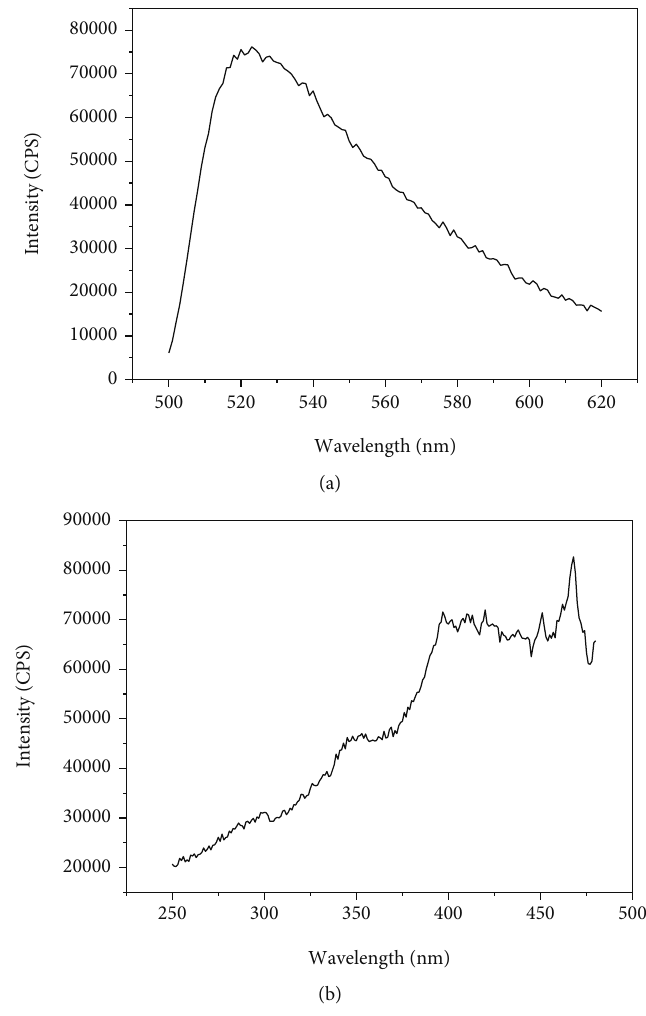
Figure 6: (a) Emission spectra and (b) excitation spectra of the